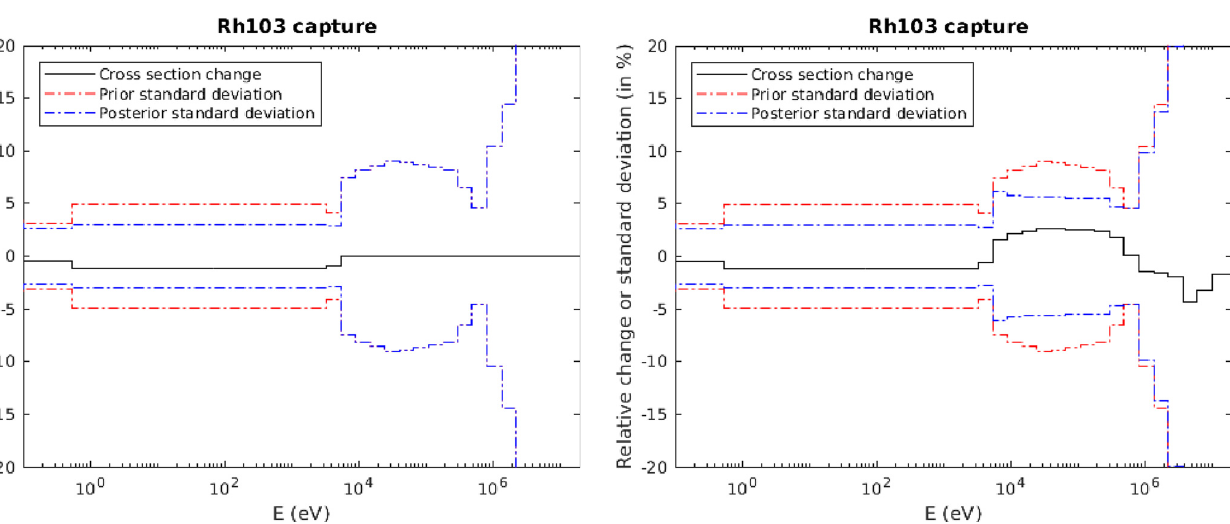
Fig. 6. Multigroup trends and associated uncertainties, by the assimilation of the MAESTRO experiment alone.